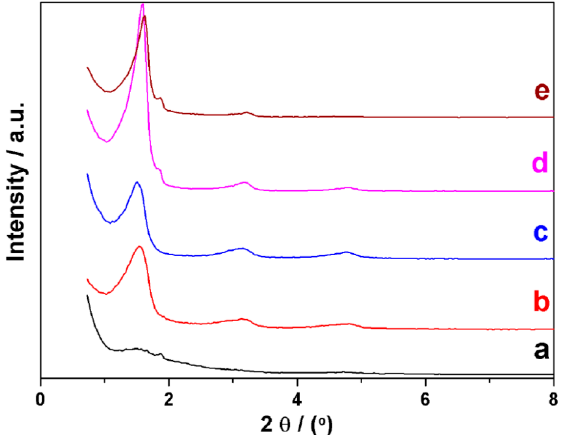
Figure 1. Low-angle X-ray powder diffraction (XRD) patterns of UVM-L16 solids synthesized by using different C16/Si molar ratio: ( a ) 0.125, ( b ) 0.25, ( c ) 0.5, ( d ) 0.75, and ( e ) 1.